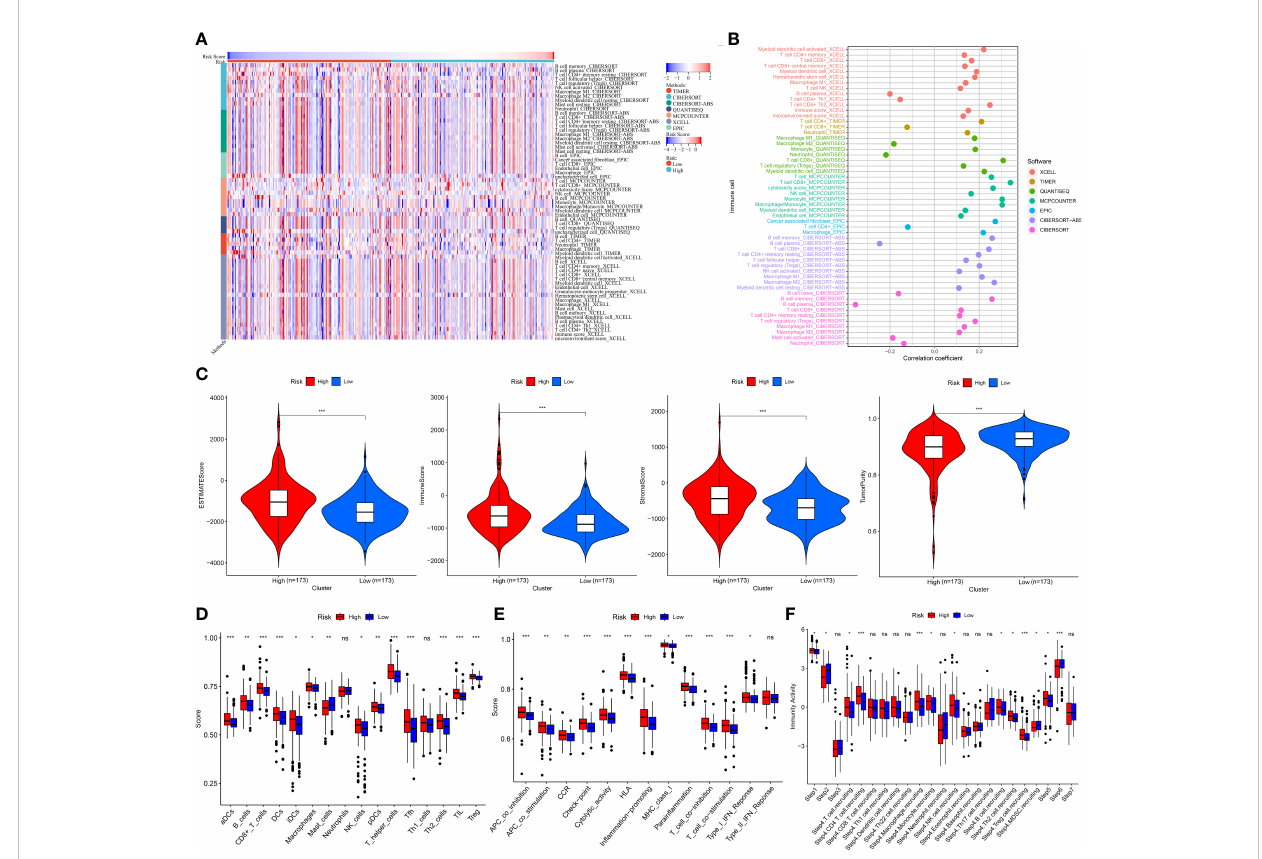
FIGURE 8 Tumor immune landscape based on MRMGPS. (A) Heatmap displaying enrichment of tumor immune-in fi ltrating cells through 7 algorithms between high- and low-risk groups. (B) Lollipop plot displaying the correlation coef fi cient of immune cells on the basis of risk score through 7 algorithms. (C) Comparison of the ESTIMATE scores, immune scores, stromal scores, and tumor purity between high- and low-risk groups. (D) Comparison of 16 cells related to immunity between high- and low-risk groups. (E) Comparison of 13 functions related to immunity between high- and low-risk groups. (F) Comparison of activity scores of each step in the cancer-immunity cycle between high- and low-risk groups. * P < 0.05, ** P < 0.01, *** P <